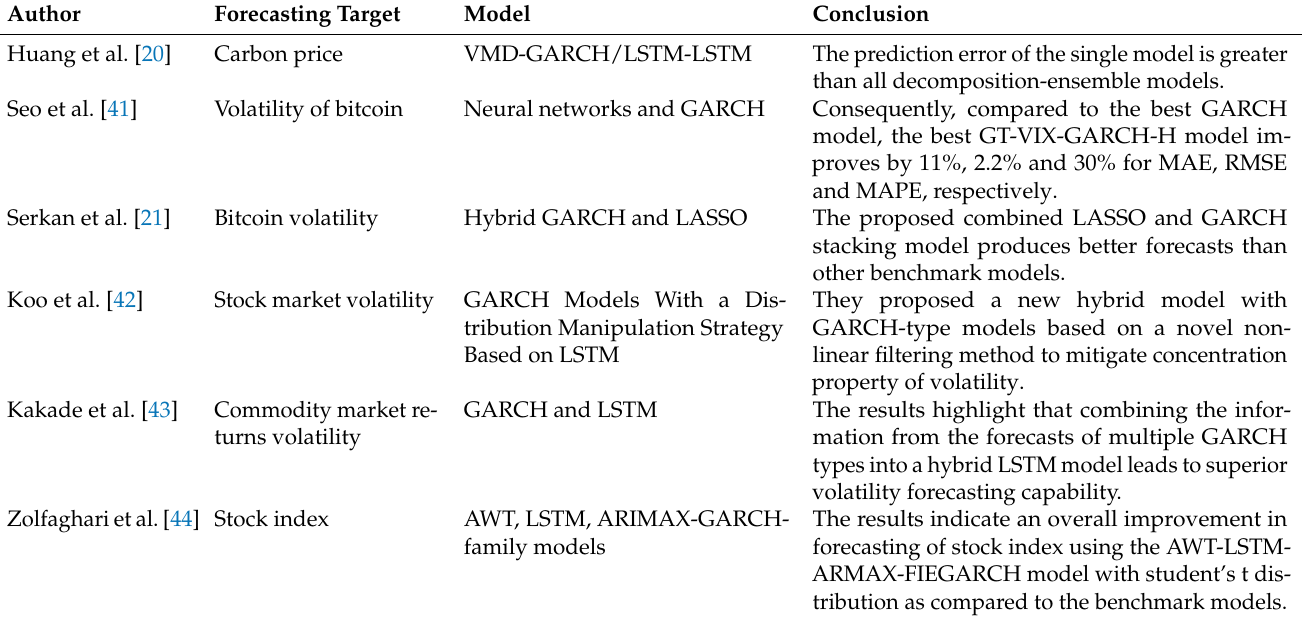
Table 1. Studies on combined models based on artificial intelligence and econometric models in general price